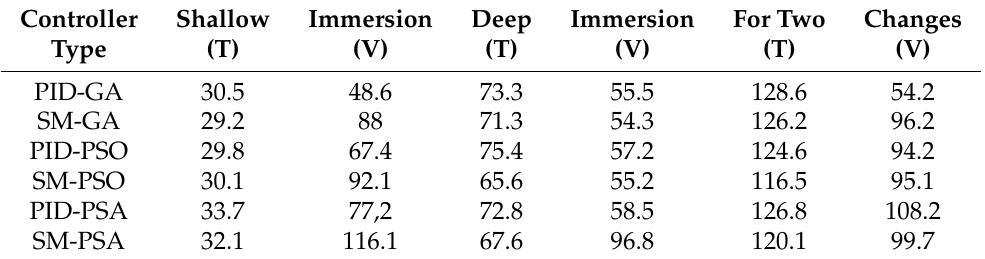
Table 2. Values of fitness function no. 1 for tuning (T) and verifying (V) BUV’s depth controllers for three changes of desired immersion: shallow, deep and two following depth changes.